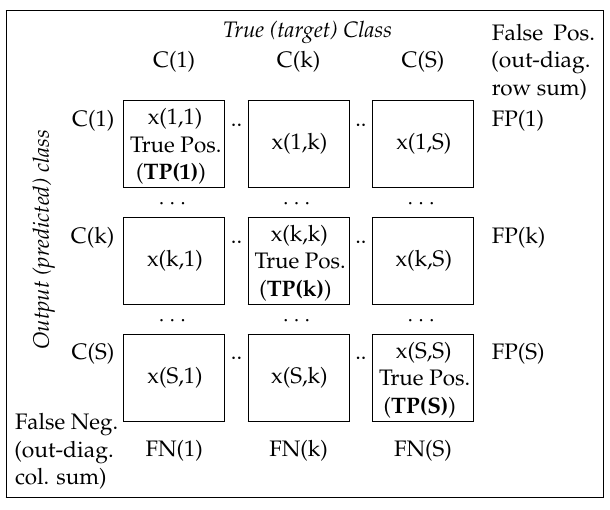
Table 2. The confusion matrix for the evaluation of a model classifying pattern vectors belonging to true (target) classes and estimating their (predicted) classes for the multi-class classification into S categories.